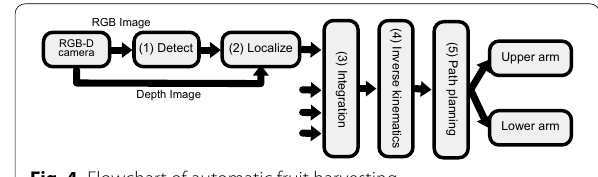
Fig. 4 Flowchart of automatic fruit